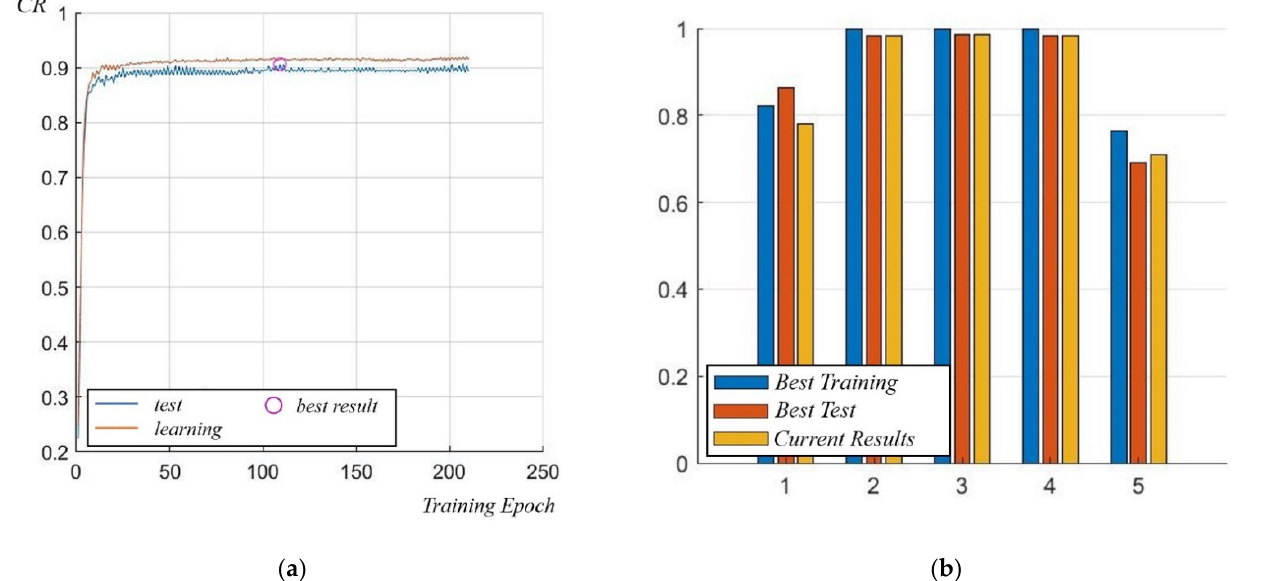
Figure 9. Classification Results; ( a ) performance of the classifier during the training phase: the red line represents the CR of the learning phase, and the blue line is the CR obtained in the test phase; ( b ) classification results for each fault class shown in the Matlab application at the end of each training epoch.